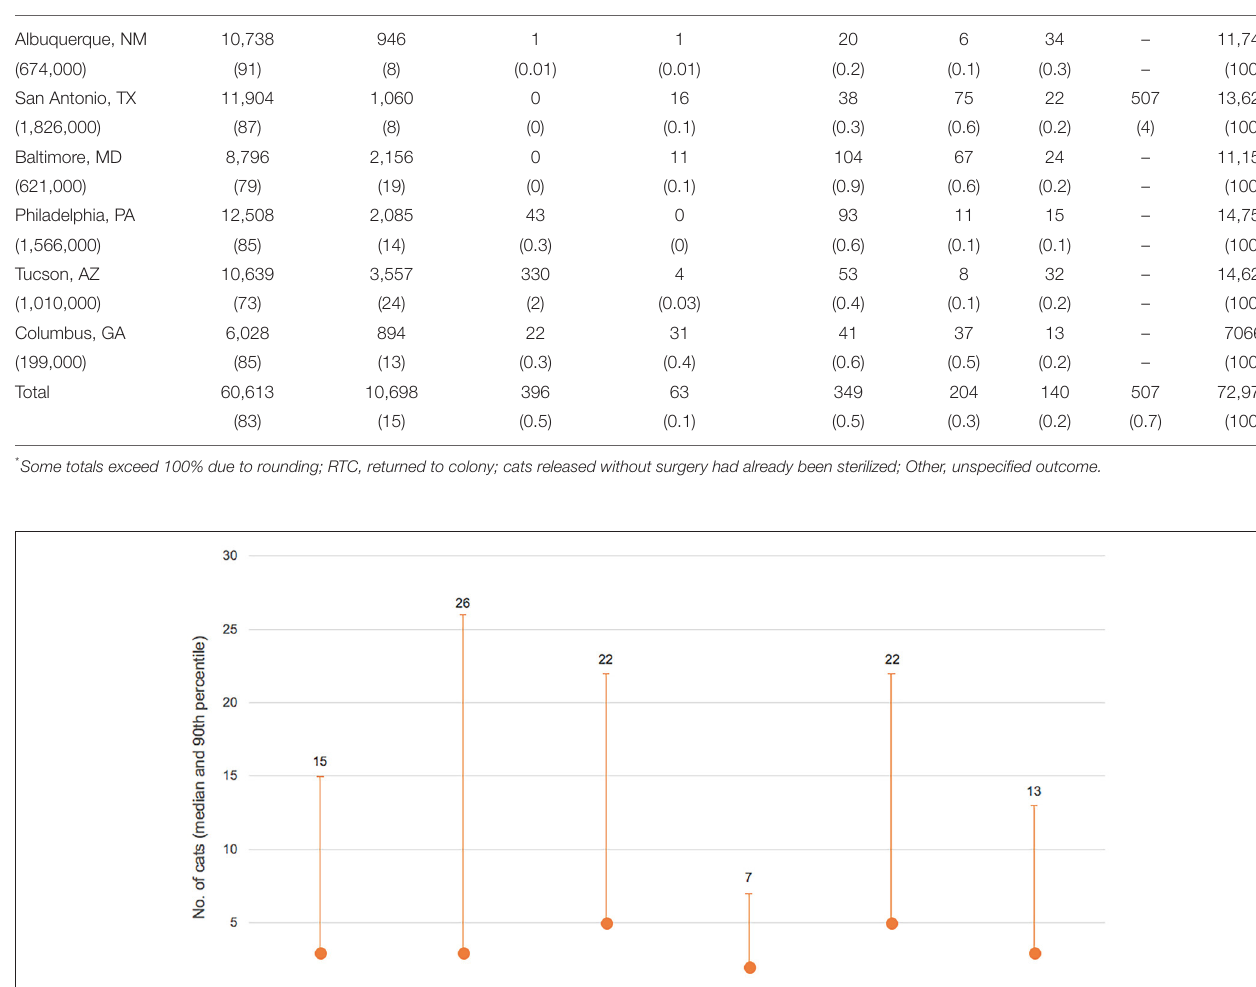
TABLE 4 | Disposition of cats in each of the six 3-year CCPs, 3-year totals and percentage by category. CCP (human population)